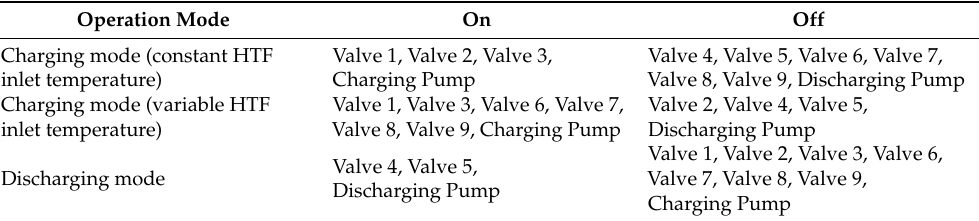
Table 2. Operation modes of the experimental platform.